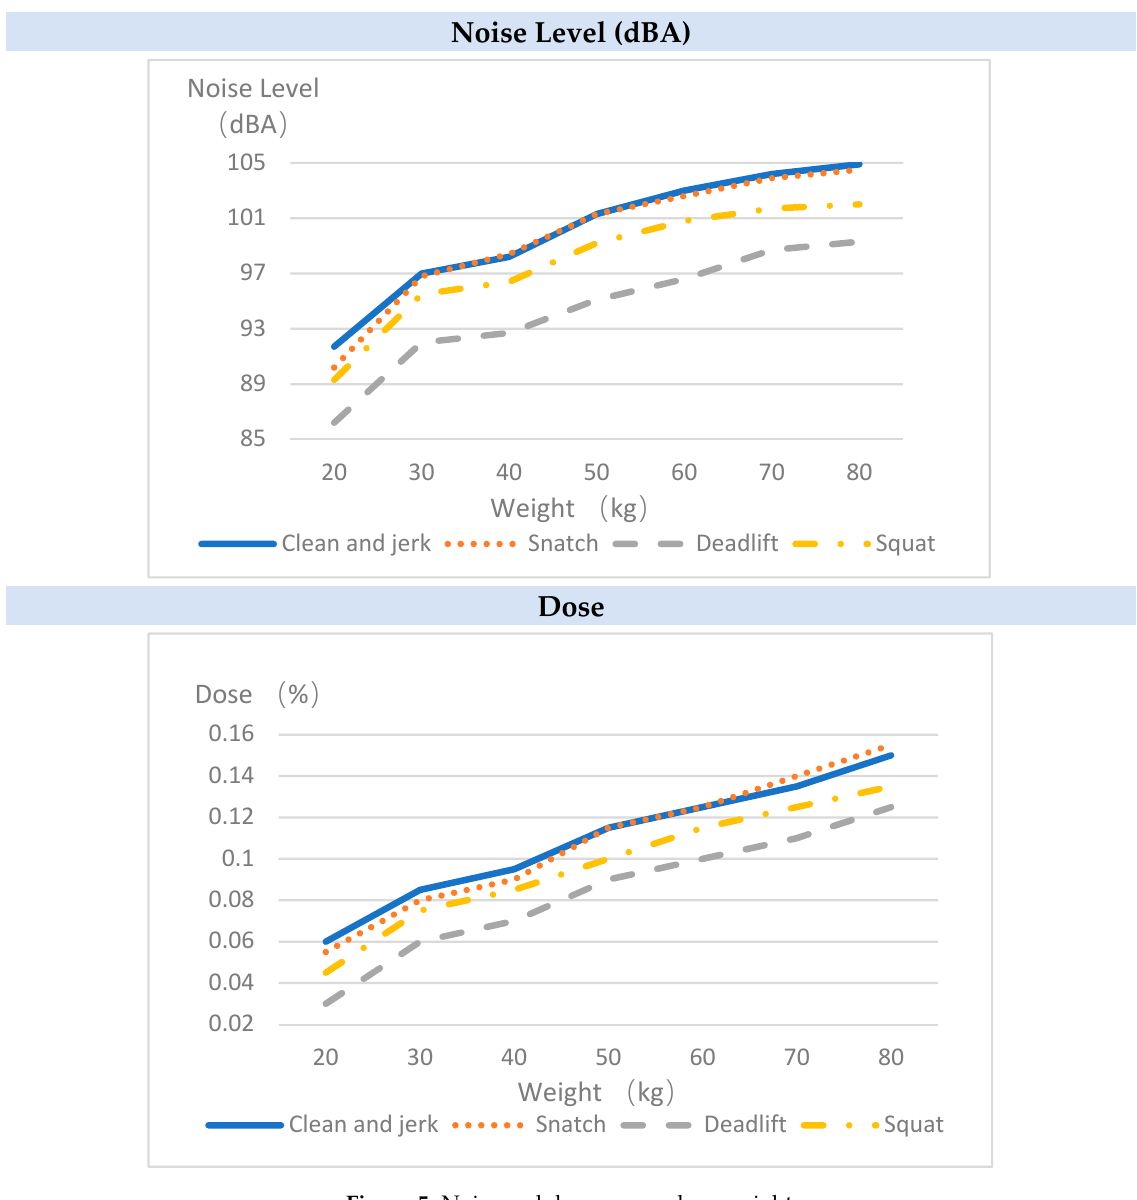
Figure 5 . Noise and dose versus drop weight. Figure 5. Noise and dose versus drop